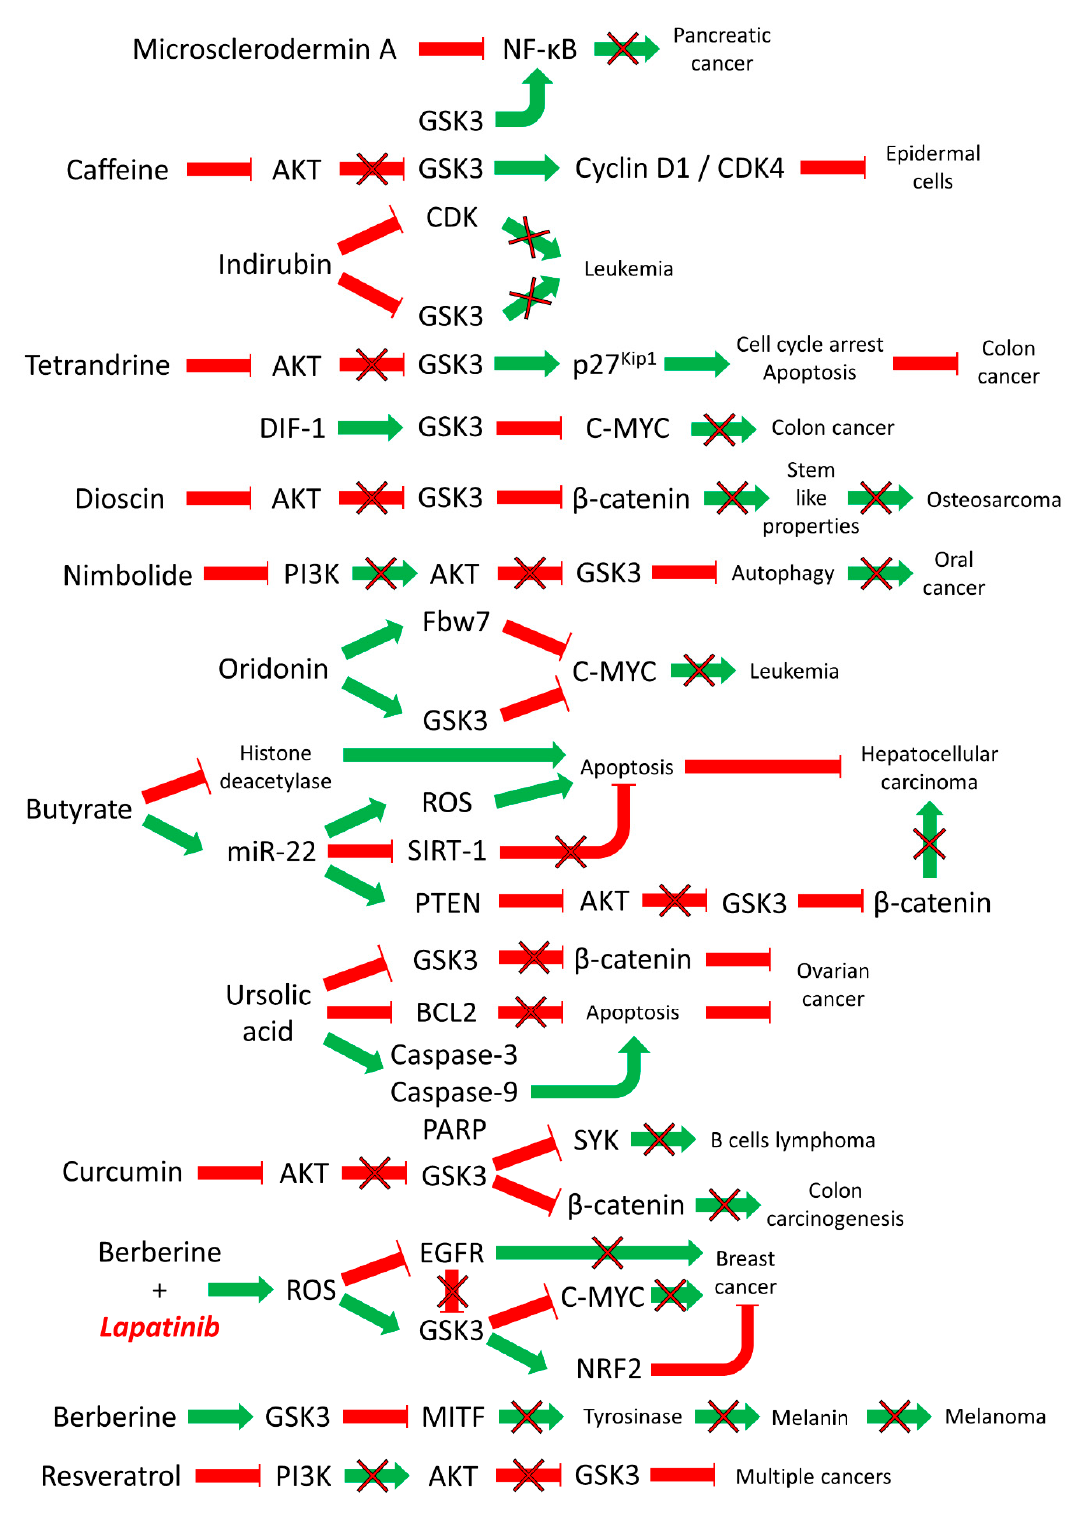
Figure 6. Effects of Natural Products on GSK-3 Activity in Various Cancers . Green arrows indicate stimulation, blocked red arrows indicate inhibition.